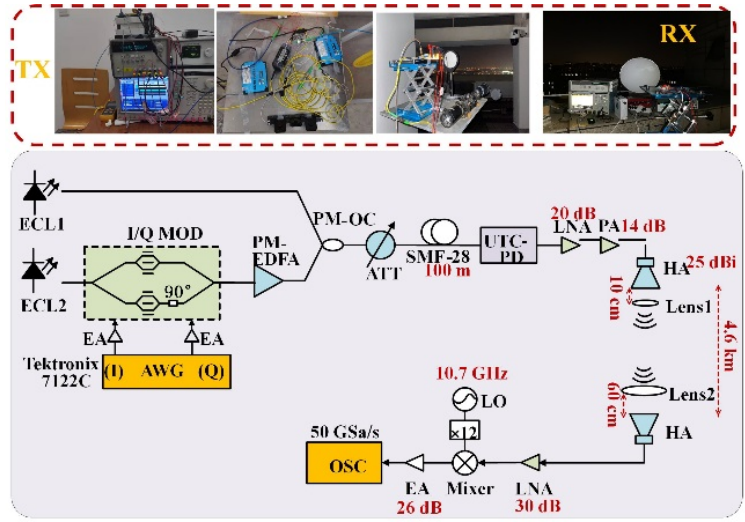
Figure 4. Experiment setup and photos of 135 GHz fiber-wireless system over 4.6 km free-space distance.